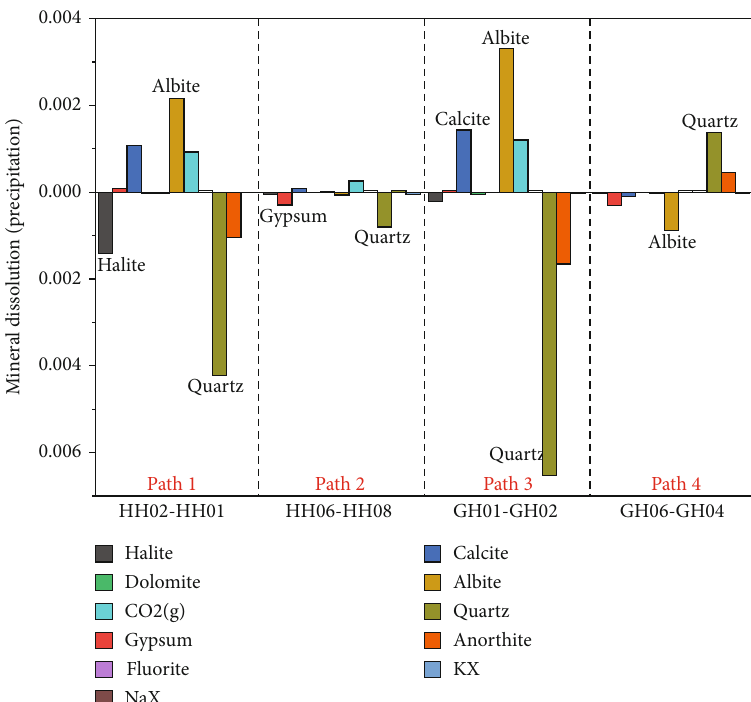
Figure 11: Mole transfer simulations in study area, Path 1 is the simulation from HH02 to the HH01 spring, Path 2 is the simulation from HH06 to the HH08 spring, Path 3 is the simulation from GH01 to the GH02 spring, and Path 4 is simulation from GH06 to the GH04